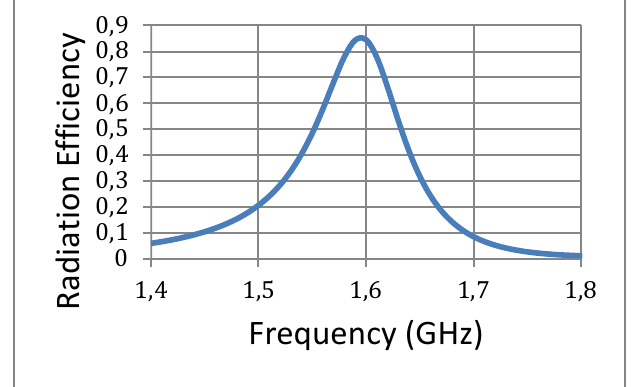
Fig. 7. Radiation efficiency vs. frequency d c = 3.5, L c = 1.1. Fig. 8. Surface current distribution on the metal screen at f = 1.4 GHz (a), 1.6 GHz (b), and 1.8 GHz (c). Such an increase means that in the passband, the NRRs and RR are strongly coupled and the AF effectively radiates energy into free space. Outside the passband, the coupling between the NRRs and RR is low and the AF does not radiate